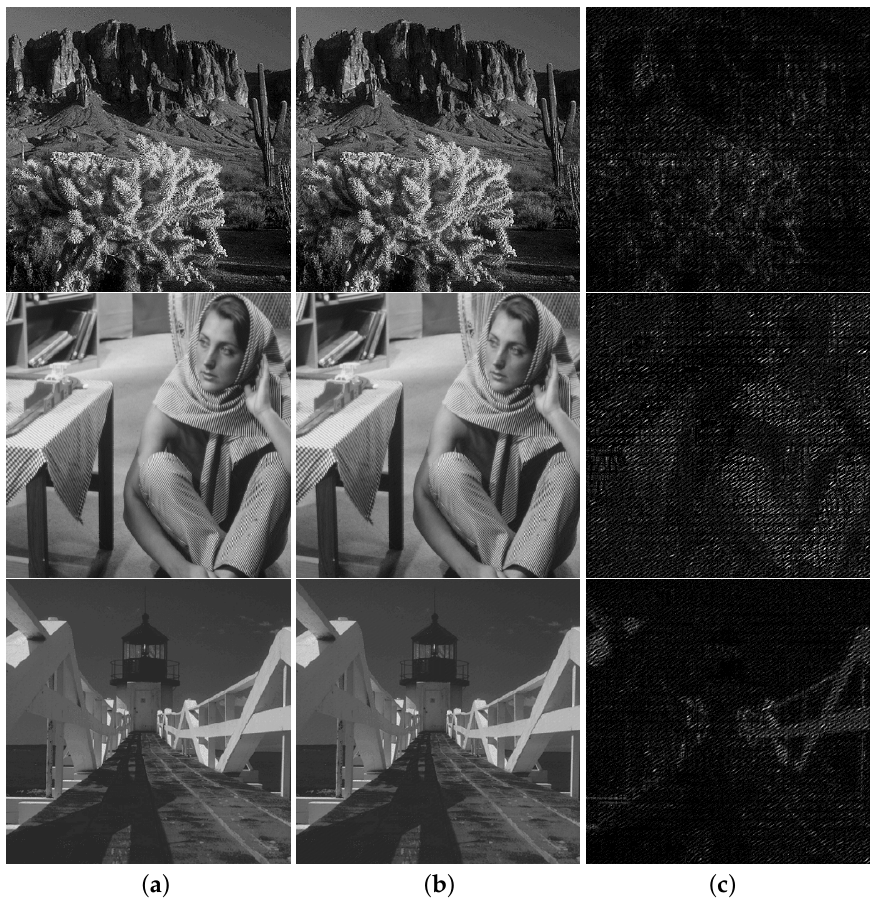
Figure 3. Examples showing invisibility: ( a ) host images, ( b ) watermarked images, and ( c ) magnified difference image, peak-signal-to-noise-ratios (PSNRs) of the first, second, and third row are 37.46 dB, 40.87 dB, and 42.13 dB,